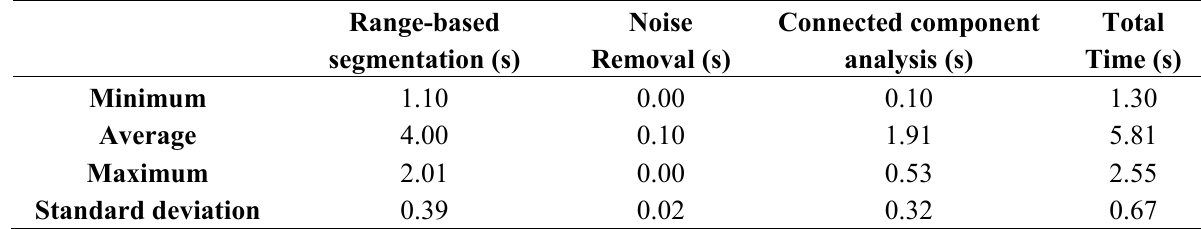
Table 1. Evaluation of the time required for a segmentation of an acquired